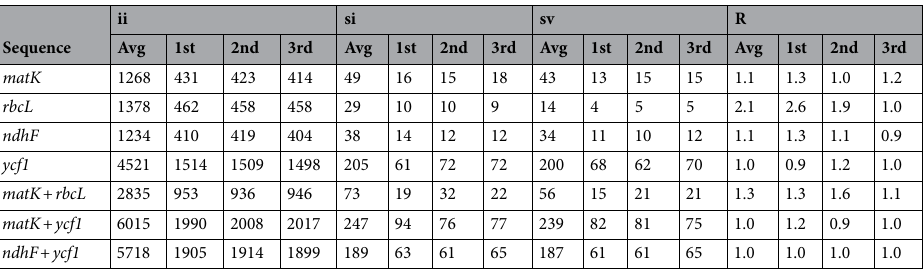
Table 2. The analysis of nucleotide pair frequencies of candidate nucleotide sequences of Orchidaceae plants. ii Identical Pairs, si Transitionsal Pairs, sv Transversional Pairs, R si/sv.